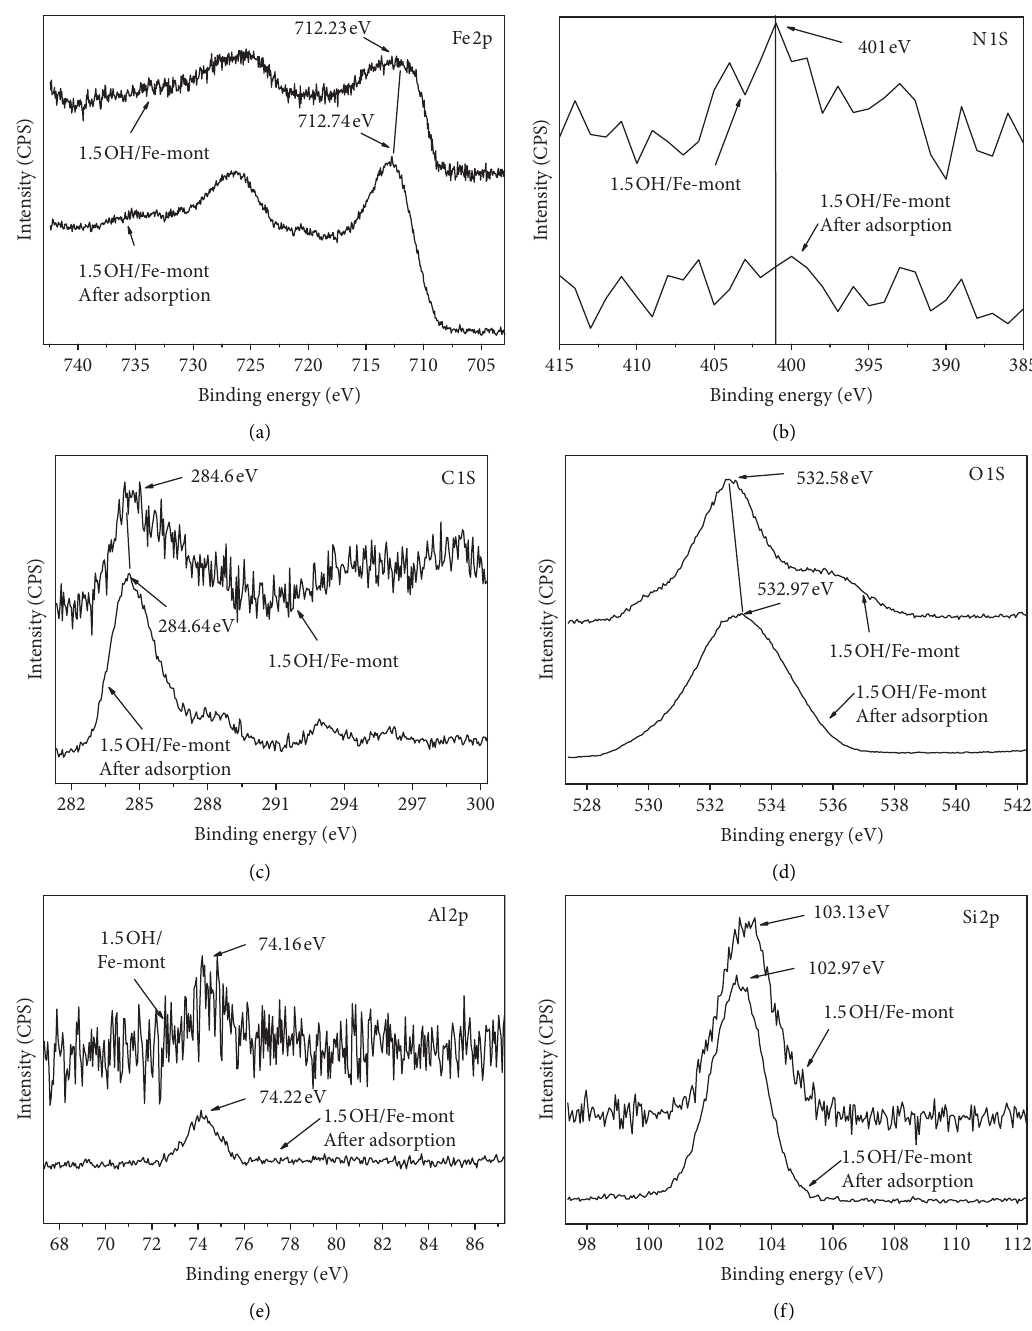
Figure 6: XPS of O1s, Al 2p, Si 2p, C1s, N1s and Fe 2p of